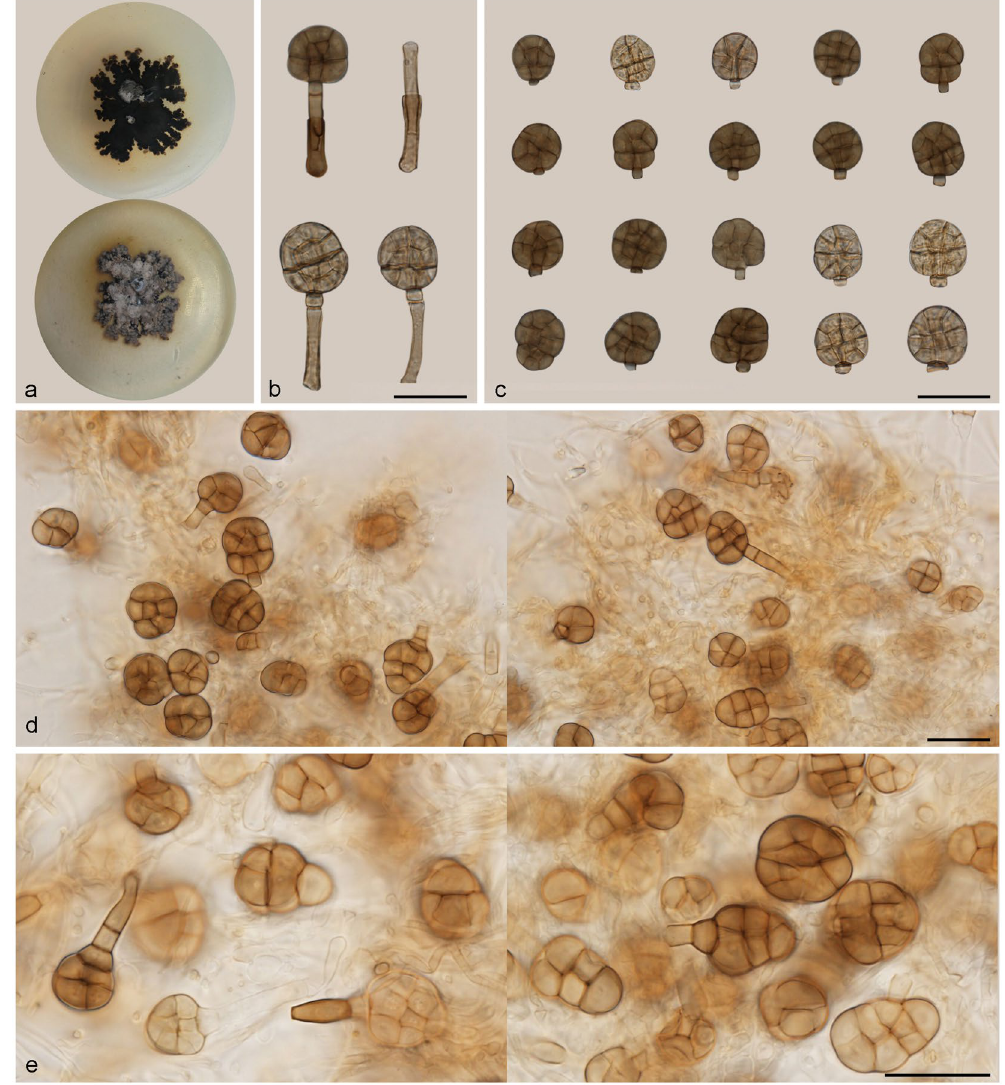
3.18655): Conidiophores and conidia. — Scale bars = 20 μ